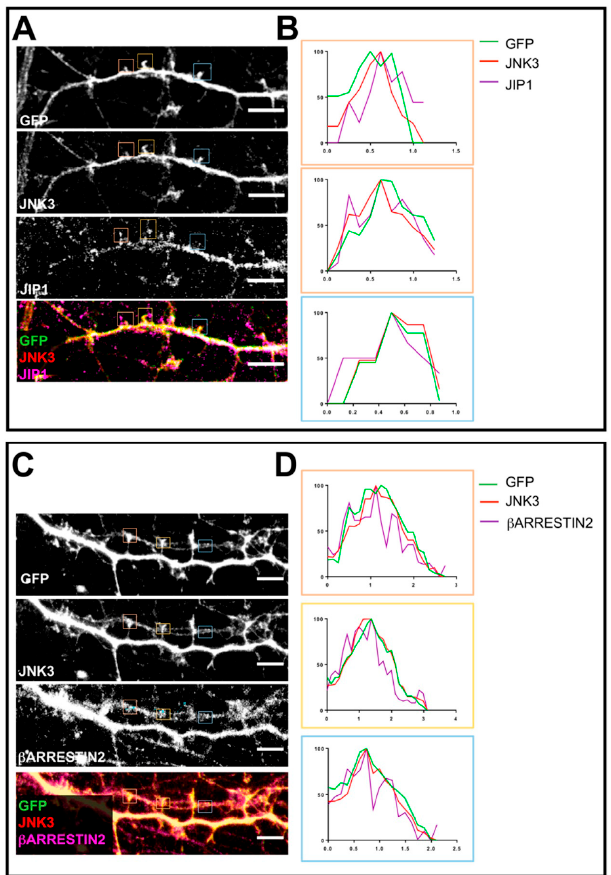
Figure 4 . Confocal microscopy outputs used to assess JNK3–JIP1– β -arrestin2–PSD95 colocalization at the dendritic spine level. ( A ) Neurons were fixed and stained with anti-JNK3 (red), anti-JIP1 (vi- olet), and anti-GFP (green). Images were obtained using a Nikon N-SIM confocal microscope and overlaid to assess protein localization. Scale bar of 50 μ m. Squares represent the loci analyzed in panel ( B ). ( B ) Intensity profile (green for GFP, red for JNK3, violet for JIP1) representing the values indicated by the squares in panel ( A ). The values are normalized to 100 (arbitrary unit). ( C ) Neurons were fixed and stained with anti-JNK3 (red), anti-ß-arrestin2 (violet), and anti-GFP (green). Images were obtained using a Nikon N-SIM confocal microscope and overlaid to assess protein localization. Scale bar of 50 μ m. Squares represent the loci analyzed in panel ( B ). ( D ) Intensity profile (green for GFP, red for JNK3, violet for ß-arrestin2) representing the values indicated by the squares in panel ( A ). The values are normalized to 100 (arbitrary unit). 2.5. Interactions of JNK3, JIP1, PSD95, and ß-Arrestin2 in Synaptic Fractions To study whether JNK3, JIP1, ß-arrestin2, and PSD95 interact in the spine, we decided to perform immunoprecipitations of JNK3, JIP1, and ß-arrestin2 from biochemically puri- fied, postsynaptic protein-enriched fractions (TIF), starting from whole-brain extracts [44]. To this end, we first confirmed that, similar to what we found in the protein extracts ob- tained from cultured hippocampal neurons, JNK3, JIP1, ß-arrestin2, and PSD95 interact in murine whole-brain extracts (Supplemental Figure S1). Next, we confirmed that the pro- teins are present in the TIF fraction (Figure 5A). We found that JNK3 and ß-arrestin2 are